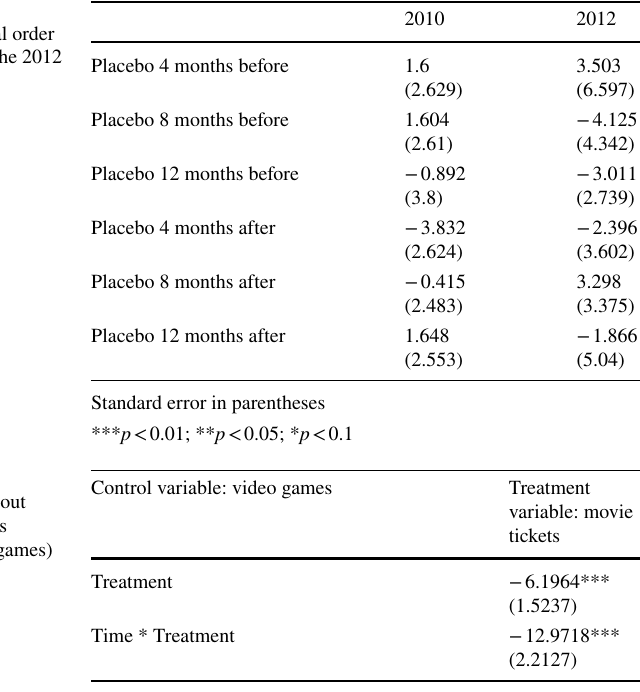
Table 6 Regression discontinuity (polynomial order 4): Placebo analysis for the 2012 and 2010 VAT reforms